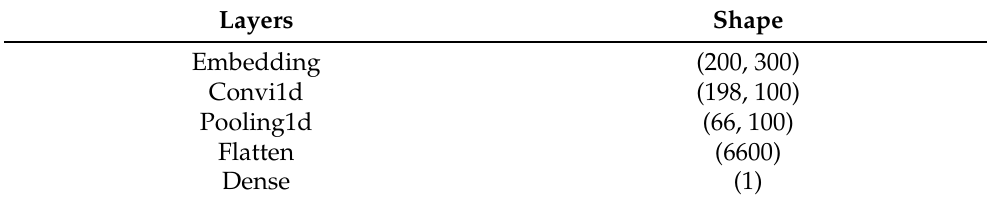
Table 2. Configuration of the CNN model proposed by Paixão et al.